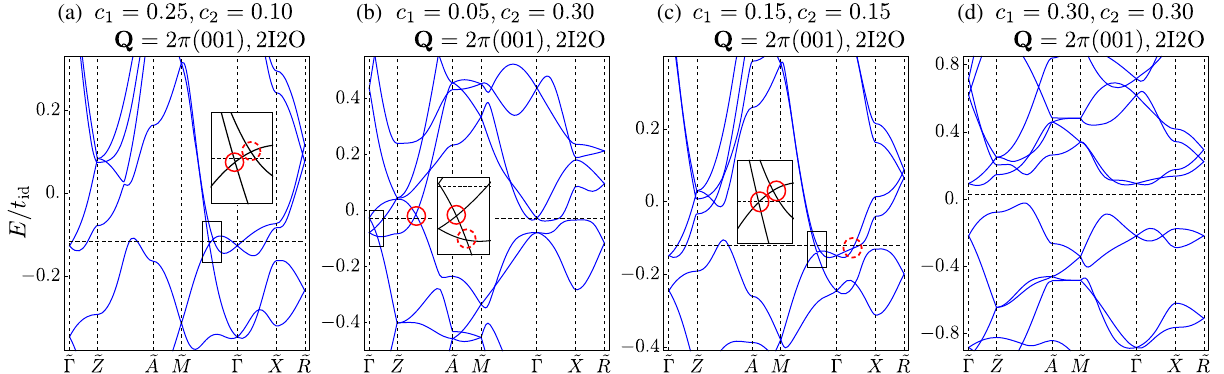
FIG. 3. Evolution of the Ir band structure as a function of f - d exchange parameters c 1 and c 2 . The dashed (solid) circle marks the usual (double) Weyl node. Here, the usual Weyl node has linear dispersions along all three momentum directions, while the double Weyl node has quadratic dispersions along two momentum directions and linear along one momentum direction [62]. For sufficiently large parameters in (d), the Weyl nodes disappear and a band gap is opened. Here, “ 2I2O ” refers to the 2-in – 2-out spin configuration. The energy unit in the plots is t . The dashed line refers to the Fermi energy. Here, only a finite energy range is plotted for clarity. See id Appendix B for the full band structures.